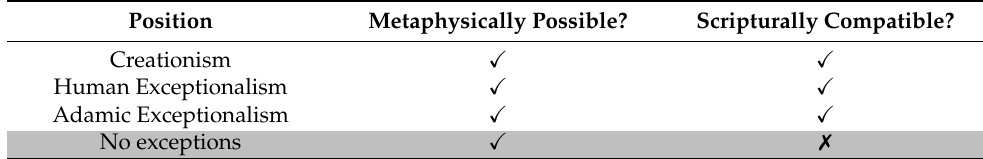
Table 3. Evaluation of the different positions. Position Metaphysically Possible? Scripturally Compatible? Creationism Human Exceptionalism Adamic